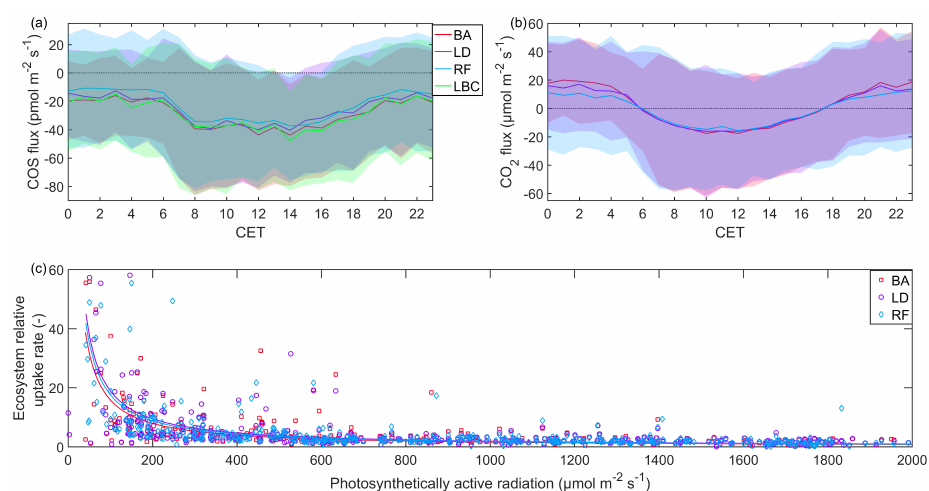
Figure 9. Mean diurnal variation of the COS (a) and CO 2 (b) exchange and light dependency of the ecosystem relative uptake rate (c) cal- culated based on different high-pass filtering scenarios (block averaging – BA, linear detrending – LD, recursive filtering – RF, linear background correction – LBC (COS only)). Data were filtered as described in the text. In addition, data shown in panel c were filtered for negative COS and CO 2 fluxes and a leaf area index ≥ 5m 2 m − 2 . CET stands for Central European